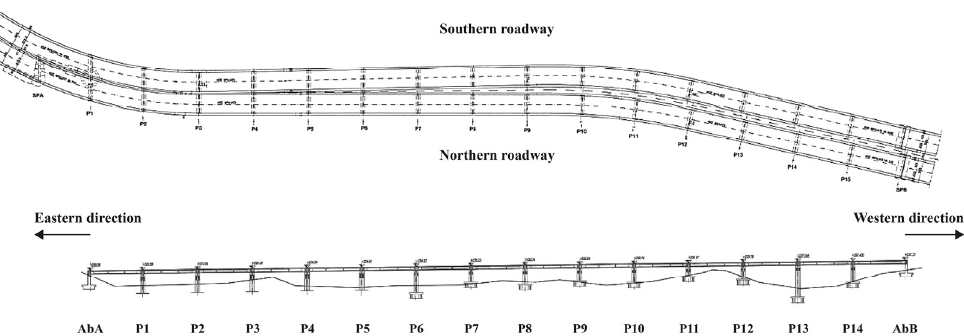
Figure 1. Elevation and plan view of the case study Vizzana-Zampogna viaduct located in central Italy.